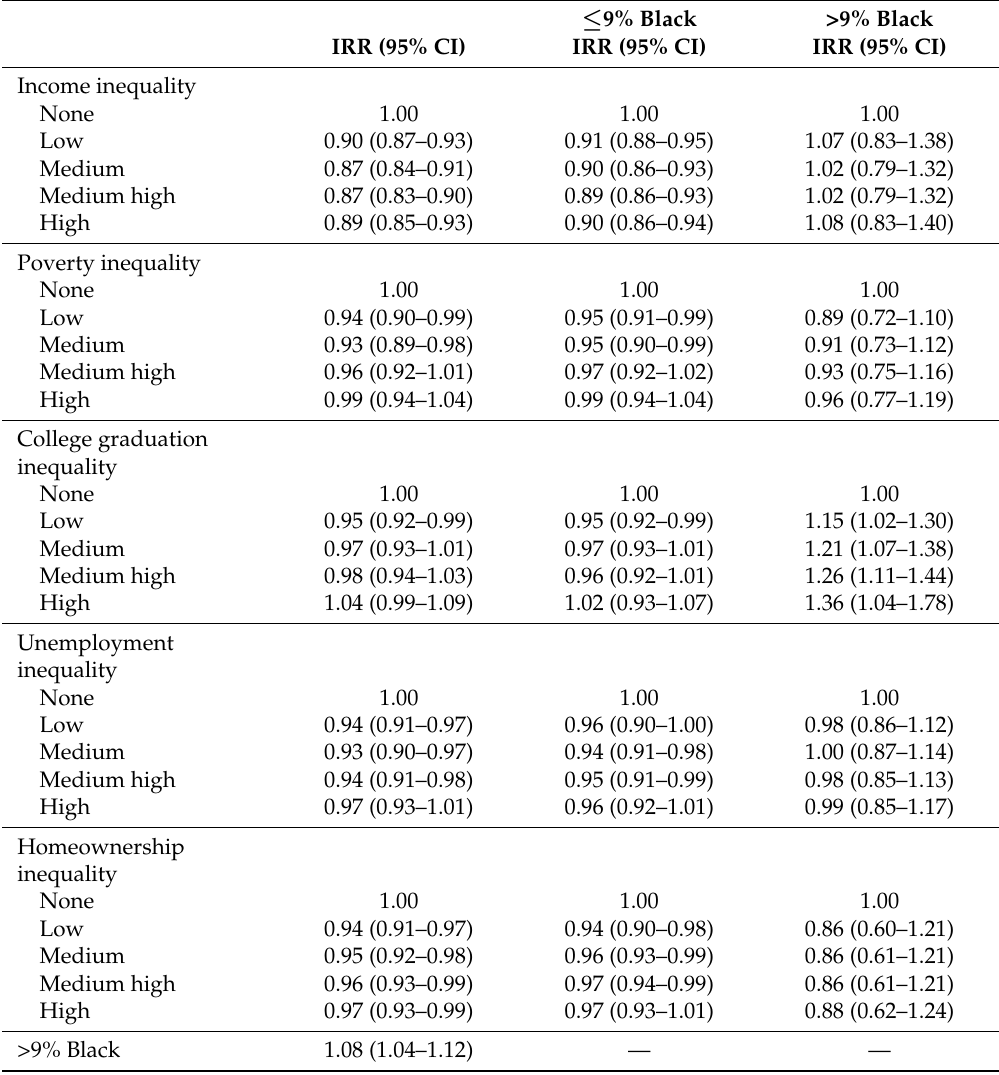
Table 3. Associations between indicators of structural racism and grocery stores by racial composition in U.S. county-years,